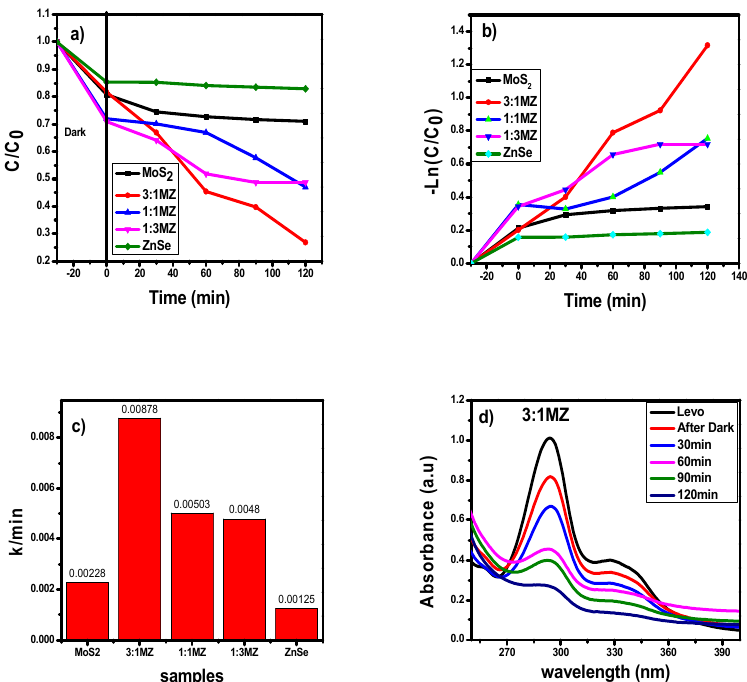
Figure 5. ( a ) Photodegradation rate of MoS 2 , ZnSe and composites, ( b ) kinetic plots of the